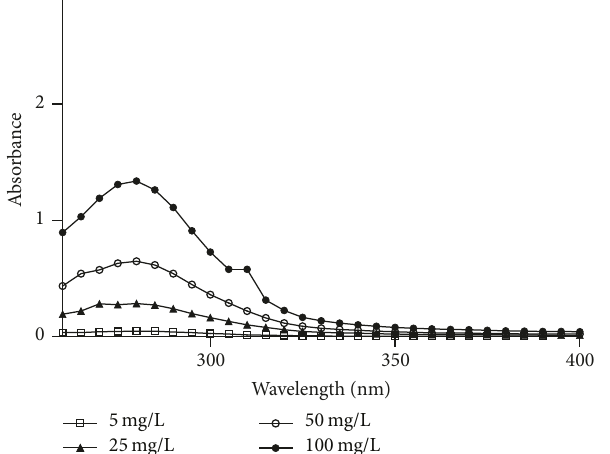
Figure 6: In vitro Sun protection factor (SPF) of Sb-EtOH